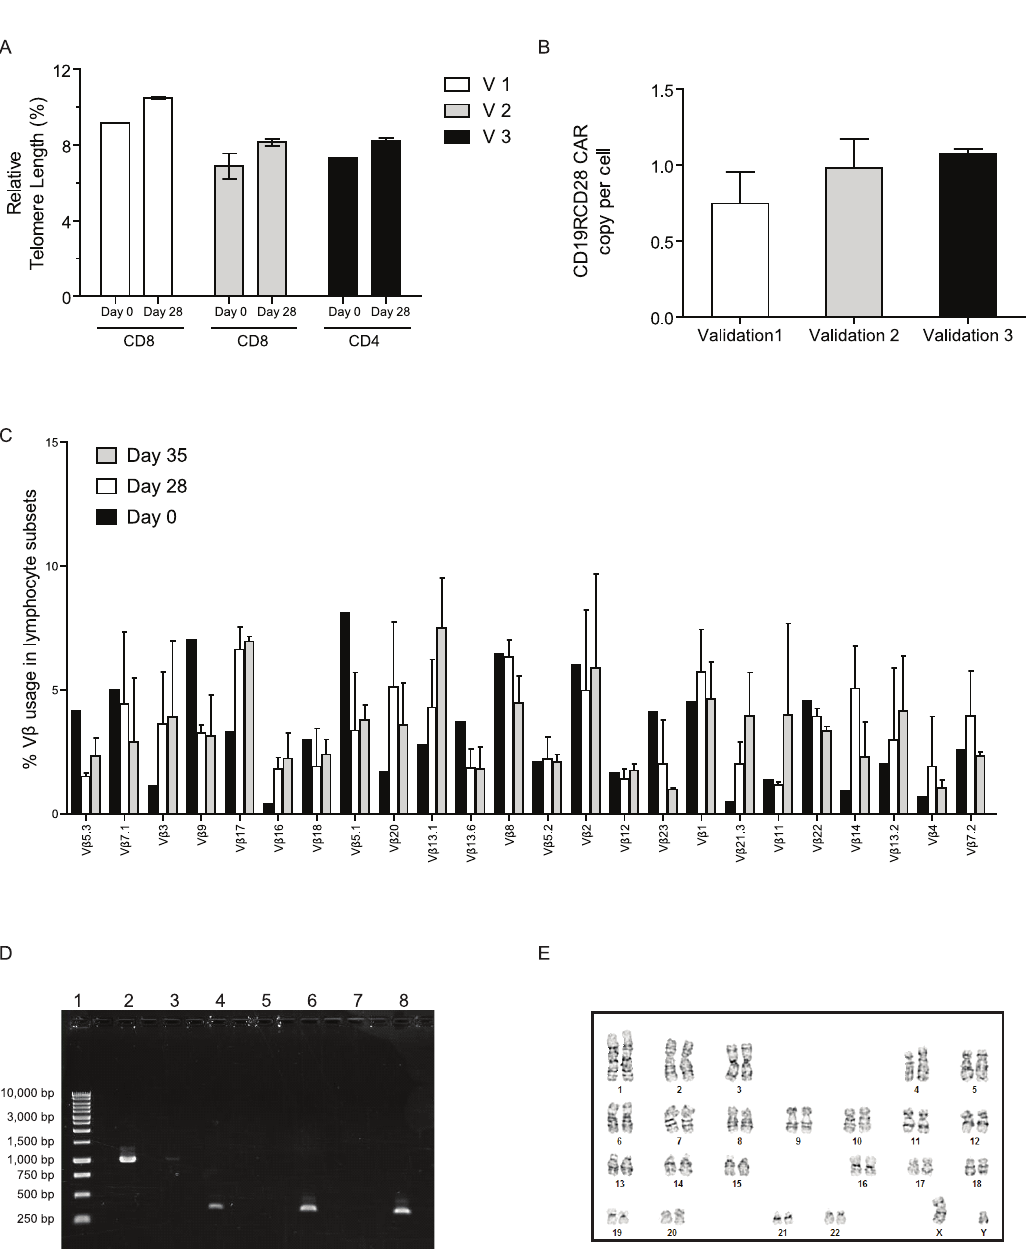
Figure 5. Safety profile associated with the SB system. (A) Telomere length of cells was measured using fluorescence in situ hybridization and flow cytometry (Flow-FISH) assay. Predominant T cell population at day 28 (V1 and V2, CD8 + T cells; V3, CD4 + T cells) was compared to respective miltenyi column purified subset of T cells from day 0. Mean 6 SD of triplicates for each validation run is represented. (B) Genomic DNA from CAR + T cells at day 28 was amplified using primers and probes specific for CD19RCD28 CAR. Relative Quantity (RQ) analyses of the CD19RCD28 target copy number was determined using normal donor PBMC as reference and endogenous RNaseP as a normalizer. Mean 6 SD of triplicates for each validation run is shown. (C) TCR V b analysis of day 28 and day 35 CAR + T cells. Data shows mean 6 SD of three validation run CAR + T cells as compared to day 0 unmanipulated controls. (D) A representative genomic PCR showing lack of SB11 transposase integration. Genomic DNA (20 ng) was amplified using SB11 or GAPDH primers. CAR neg control T cells (lane 5) and CAR + T cells (lane 7) amplified using SB11 primers; CAR neg control T cells (lane 6), CAR + T cells (lane 8) and Jurkat stably expressing SB11 (lane 4) amplified using GAPDH primers. Jurkat stably expressing SB11 (Jurkat/ SB11-IRES2-EGFP) (lane 3) and the linearized plasmid, pKan-CMV-SB11 (lane 2) amplified using SB11 primers were used as positive controls. (E) G- banded karyotypes of CAR + T cells from the three validation runs reveal no structural or numeric alteration. A representative spread from validation 2 is